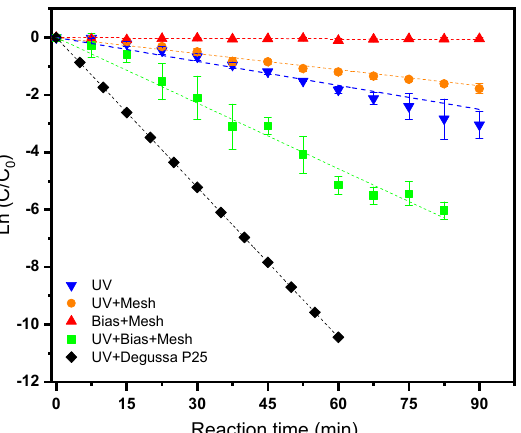
Figure A3. Fitted data by applying the Langmuir-Hinshelwood model reduced to a first order kinetics.